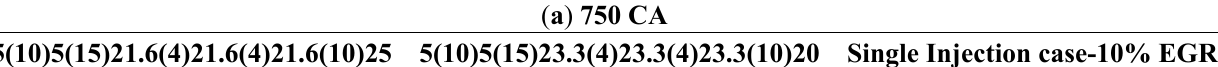
Figure 15. Temperature, NO